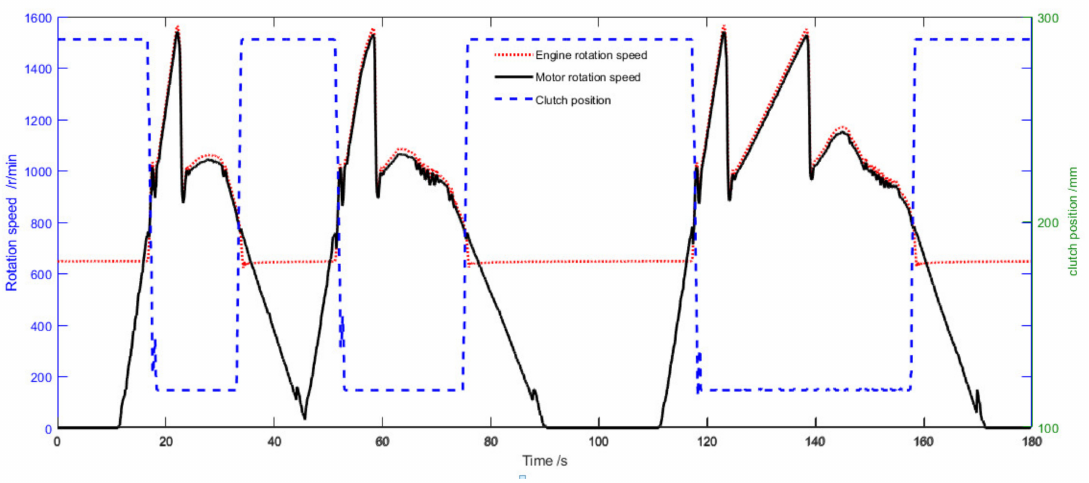
Figure 21. Process of the engine simulation